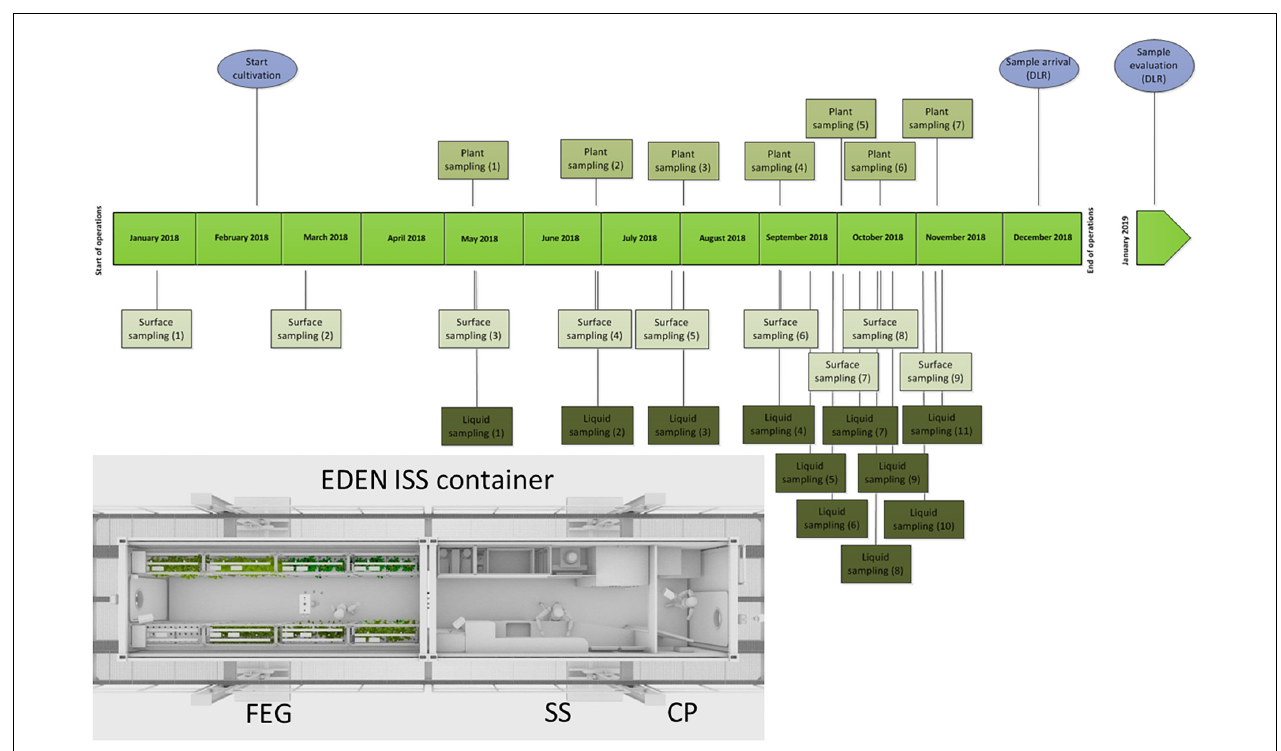
FIGURE 1 | Schedule of the sampling events in the EDEN ISS container from January to December 2018; light blue: special events. Overview of the EDEN ISS container with its three compartments: cold porch (CP), service section (SS), future exploration greenhouse